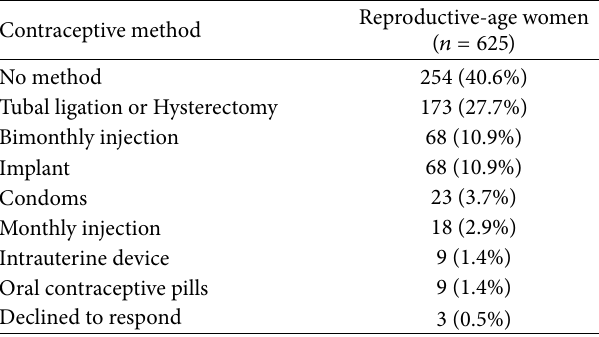
Table 1: Modern contraceptive use among surveyed women aged 16 to 50 in 2016−2017.